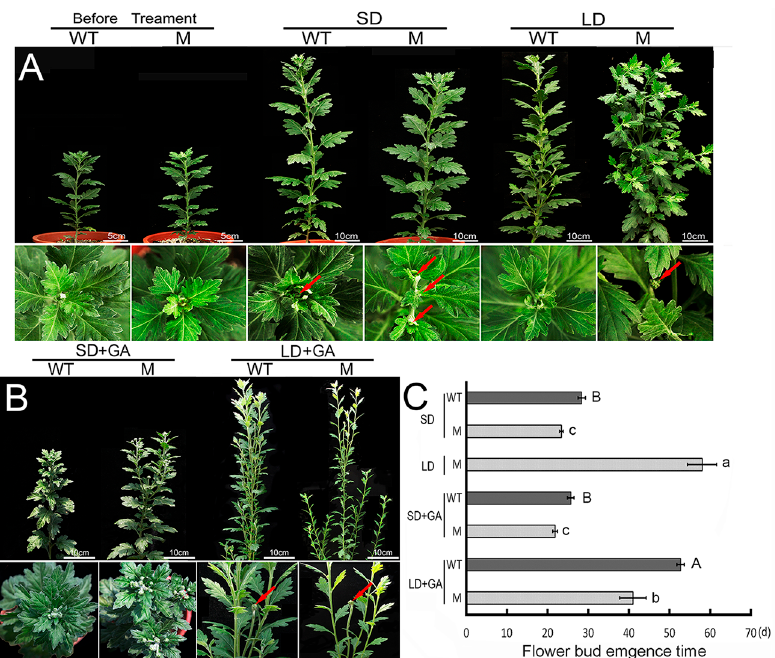
Figure 1. The switch to reproductive growth in WT and M chrysanthemum plant. ( A ) Flower bud emergence (arrowed) in plants grown under LD or SD; ( B ) Flower bud emergence (arrowed) induced by spraying plants with GA under LD or SD; ( C ) The effect of GA application on the timing of flower bud emergence. Significant differences were determined by Duncan’s multiple range test ( p < 0.05); error bar indicates SD. Different uppercase ( A , B ) or lowercase (a–c) letters indicate significant differences in the time required for WT and M plants, respectively.